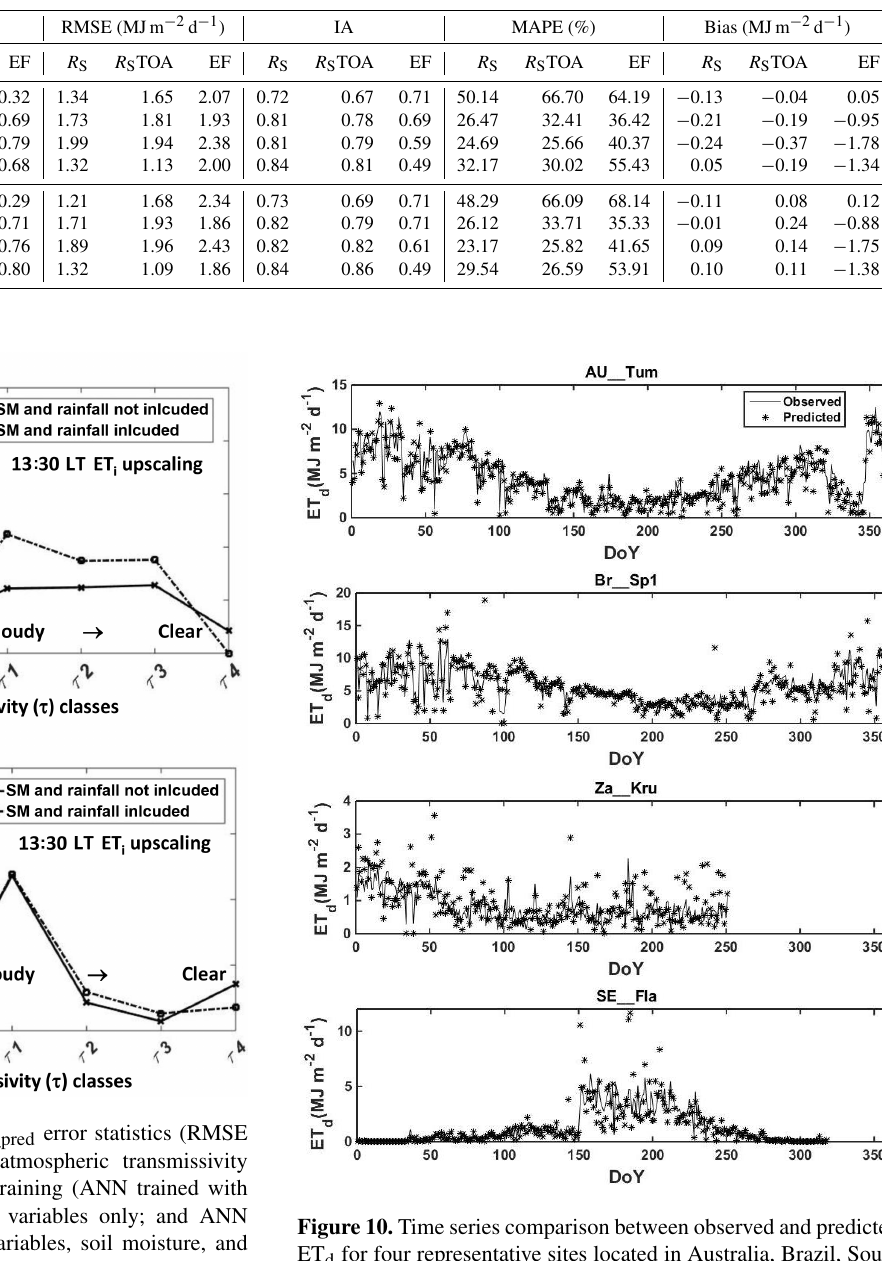
and lower bias; Table 2) which is in agreement with the find- ings from Ryu et al. (2012). Due to their comparable error statistics, an intercomparison of R S and R S TOA-based meth- ods of ET i upscaling was also carried out across different